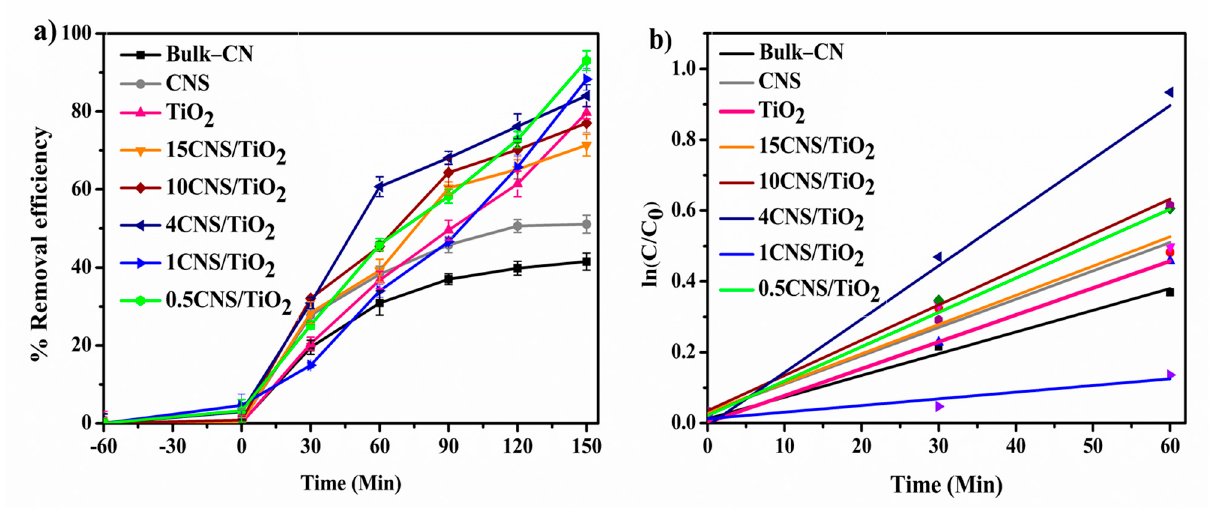
Figure 5. ( a ) Photocatalytic degradation of imidacloprid when treated with g - C 3 N 4 , TiO 2 , and g-C 3 N 4 /TiO 2 composites under UV - Vis light irradiation (10 ppm of pesticide and 1g / L of catalyst loading), and ( b ) the first-order kinetic fitting curve of the photocatalytic IMI degradation during 30 min irradiation time.